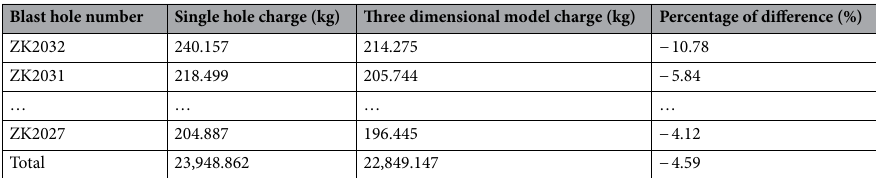
Table 7. Comparison of blast hole